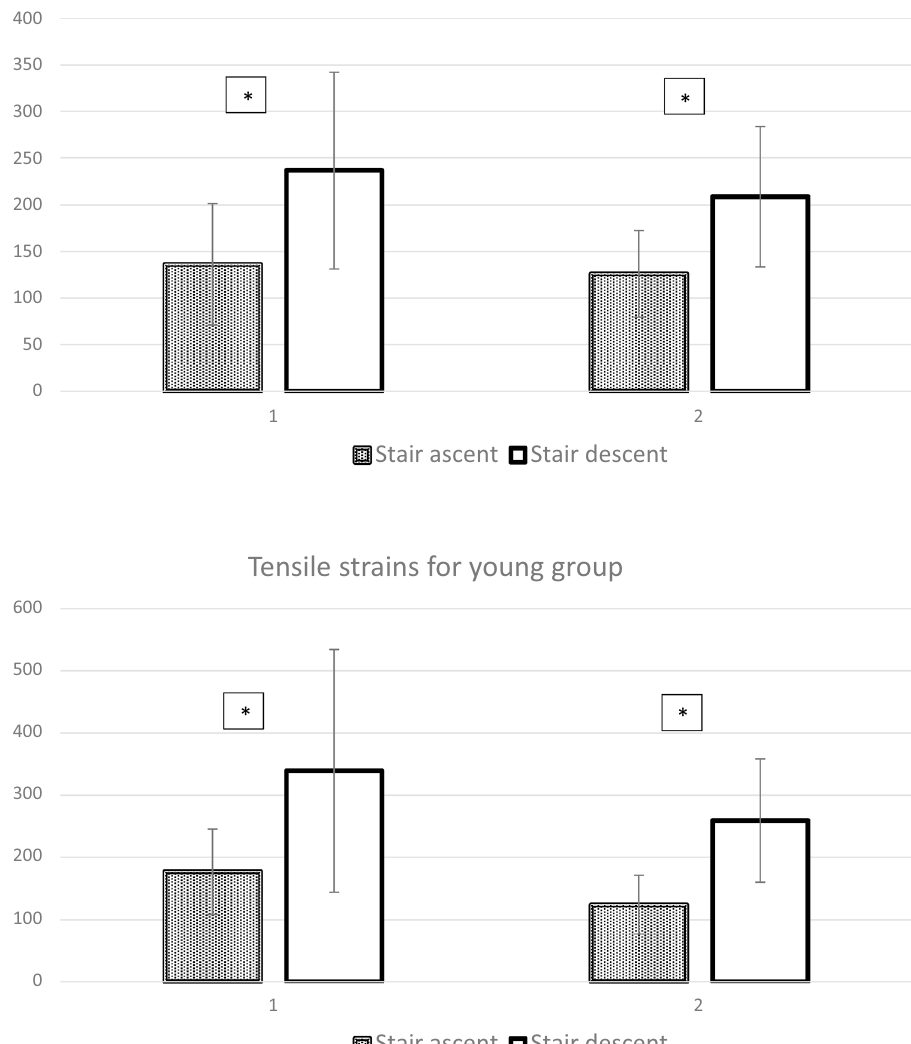
Figure 2. The averaged peak tensile strains (unit: µε) for older and young groups (Means ± SD). In Horizontal axis, 1 indicated peak 1, 2 indicated peak 2. *Stands for the significant difference comparing to stair descent ( P <